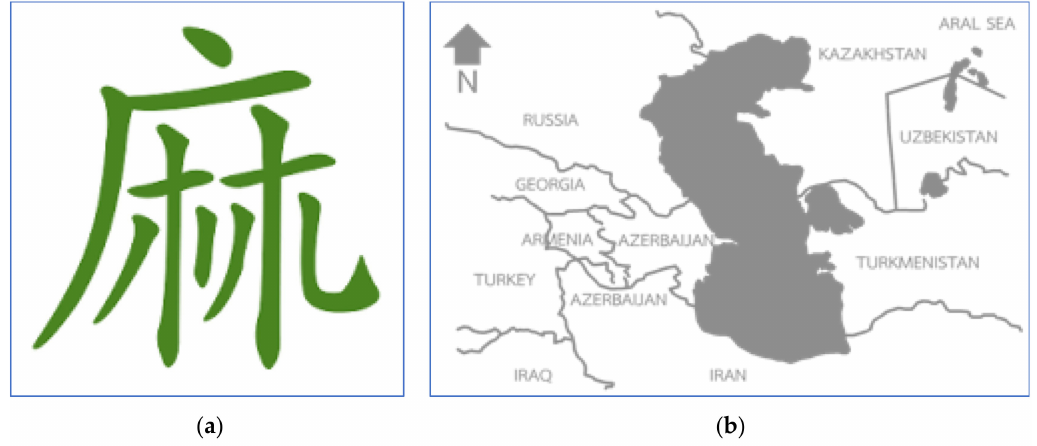
Figure 1. The evolution of the Chinese characters of the word “ Cannabis sativa ” or “Ma” ( a ) and the place of origin of the cannabis plant in the southern Caspian sea near Iran ( b